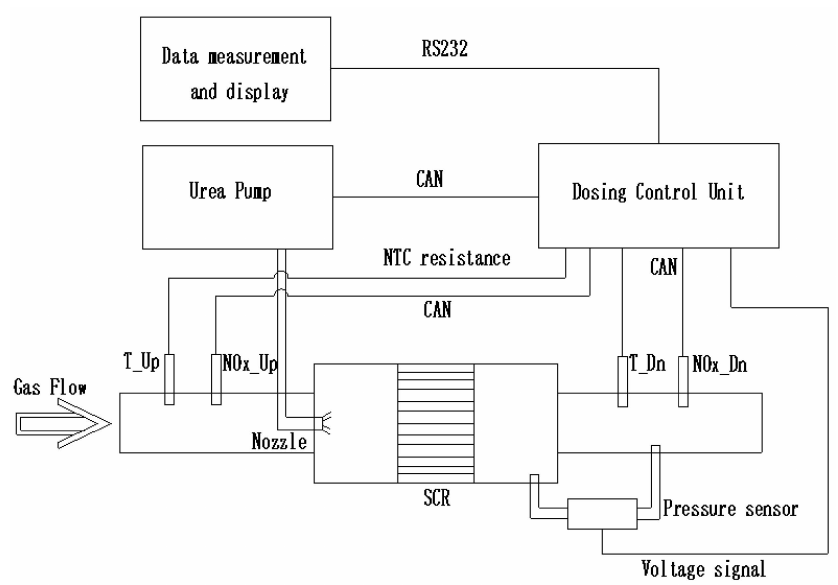
Figure 1. Schematic diagram of the experimental setup and test